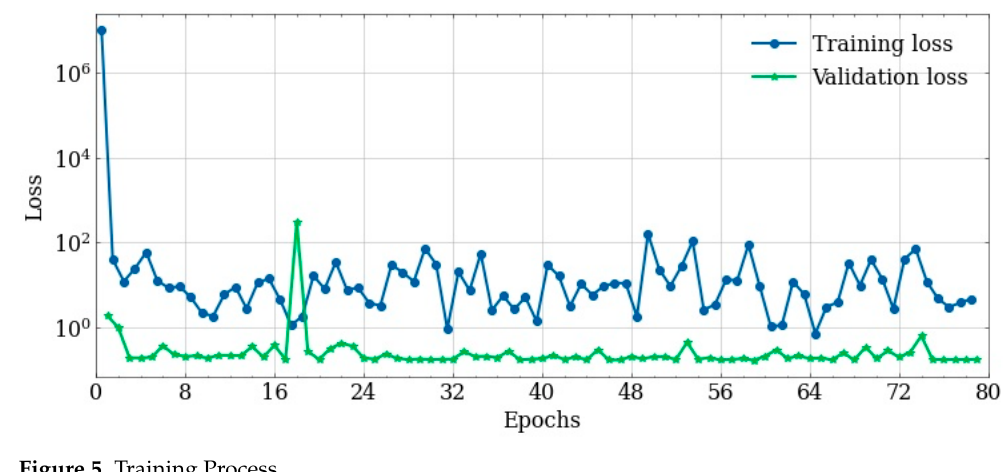
Figure 5. Training Process. Figure 5. Training Table 2. Network Model Hyperparameters Setting.